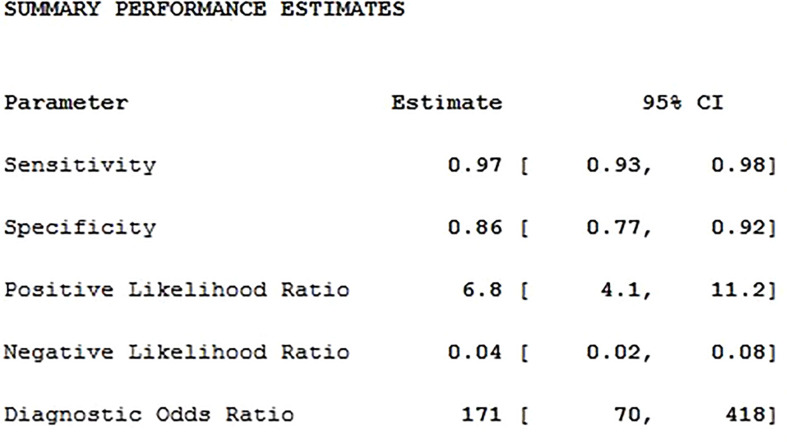
The combined statistics.